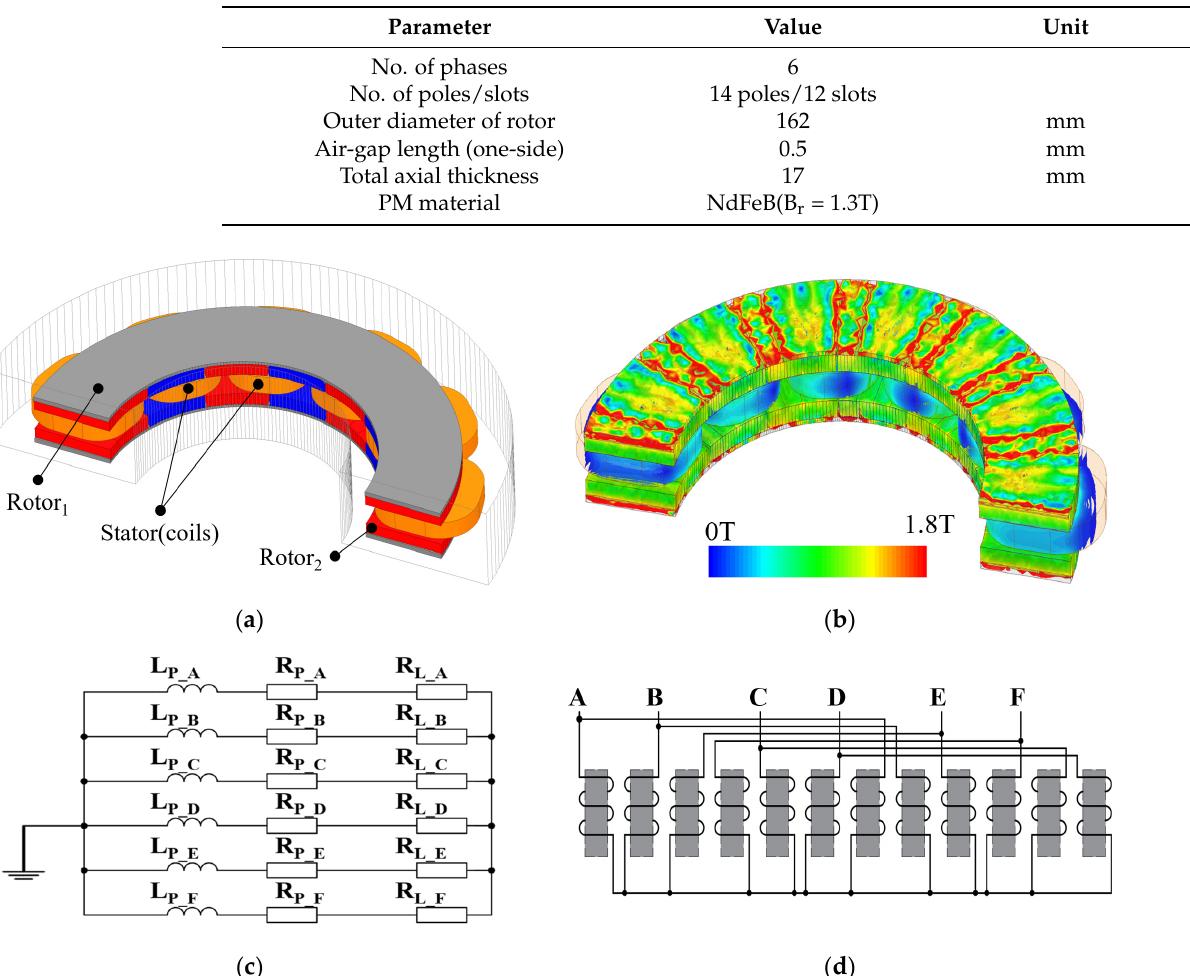
Table 2. Initial design results for the AFPM generator.